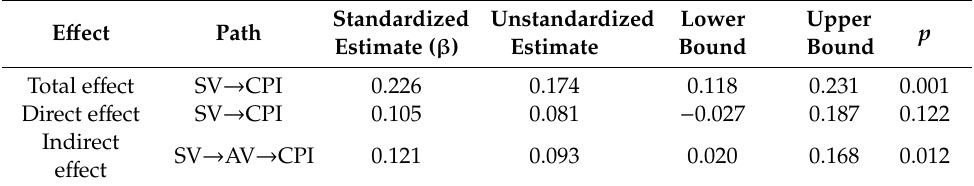
Table 6. Indirect e ff ect of perceived social value on continuous participation intention.